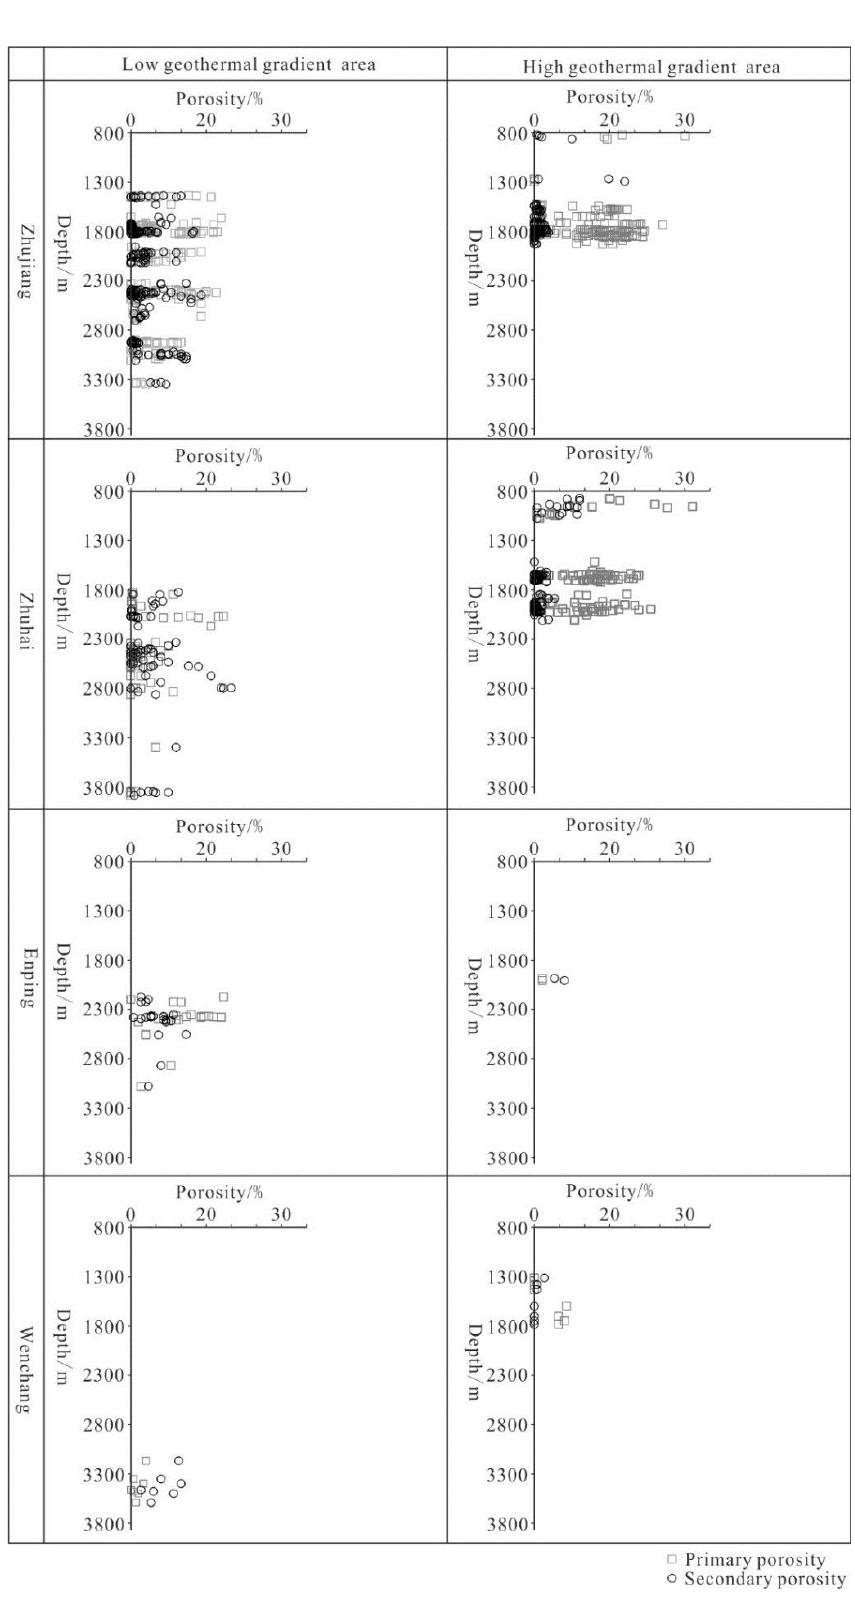
Figure 3. Distribution of primary and secondary pores in the different geothermal gradient areas.